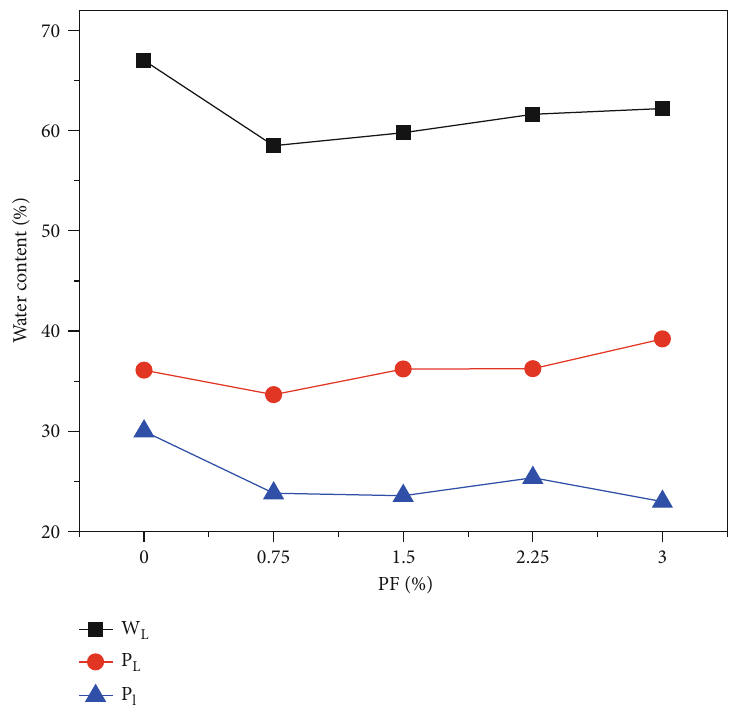
Figure 4: E ff ect of PF on the Atterberg limits of the